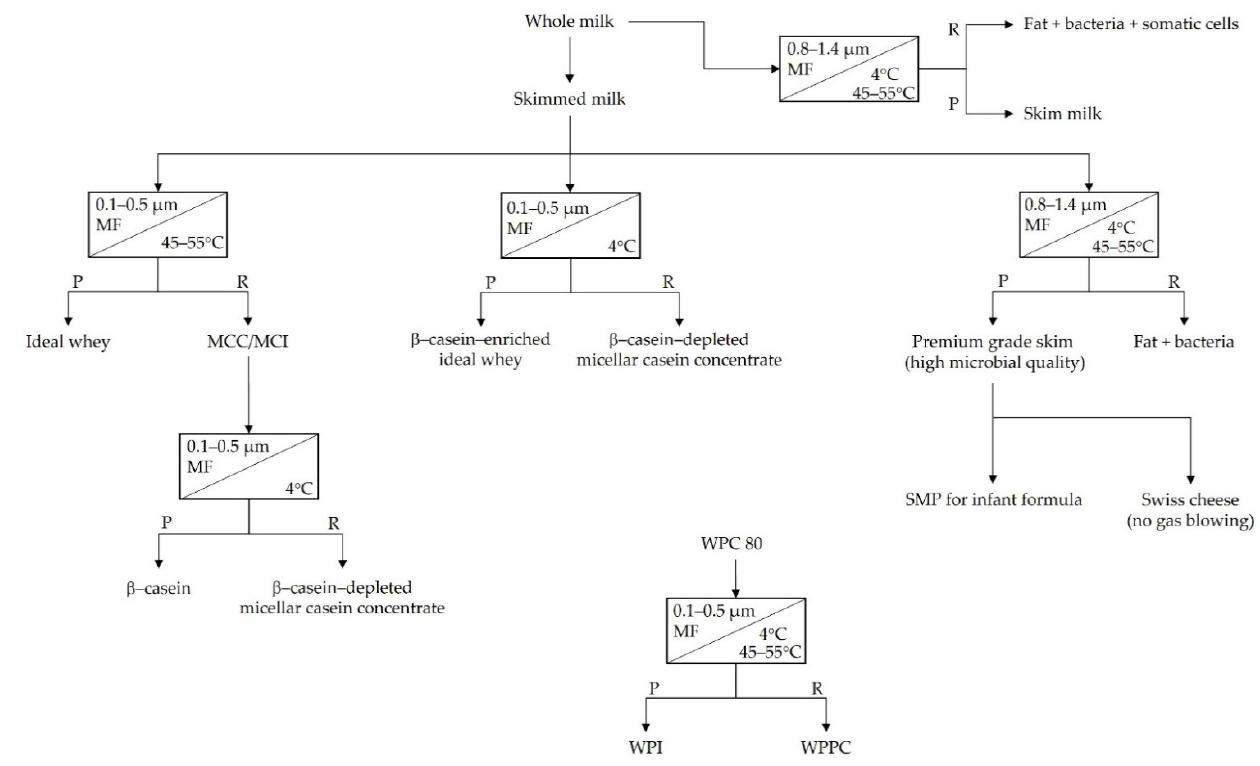
Figure 4. Schematic representation of the use of microfiltration (MF) to improve microbiological quality and generation of different milk protein-derived ingredients as influenced by processing temperature. MCC, micellar casein concen- trate; MCI, micellar casein isolate; SMP, skim milk powder; WPC, whey protein concentrate; WPI, whey protein isolate; WPPC, whey protein phospholipid concentrate; P, permeate; R,